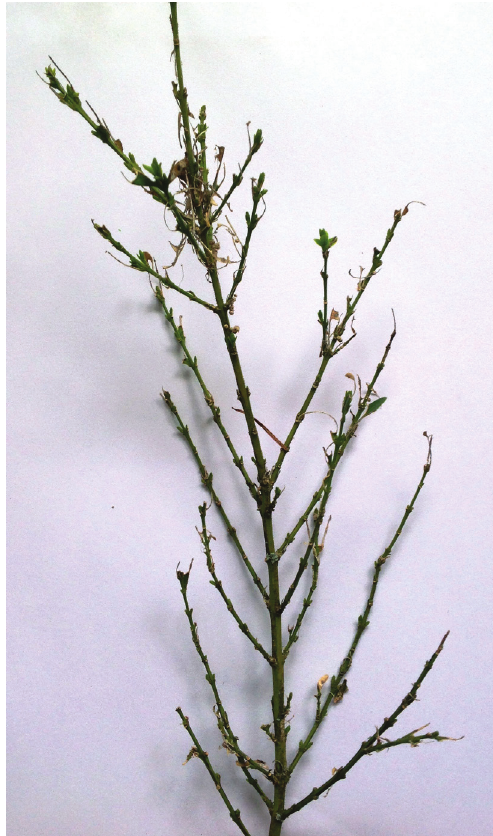
FIGURE 5. Total defoliation of box leaves, only midribs are left (September